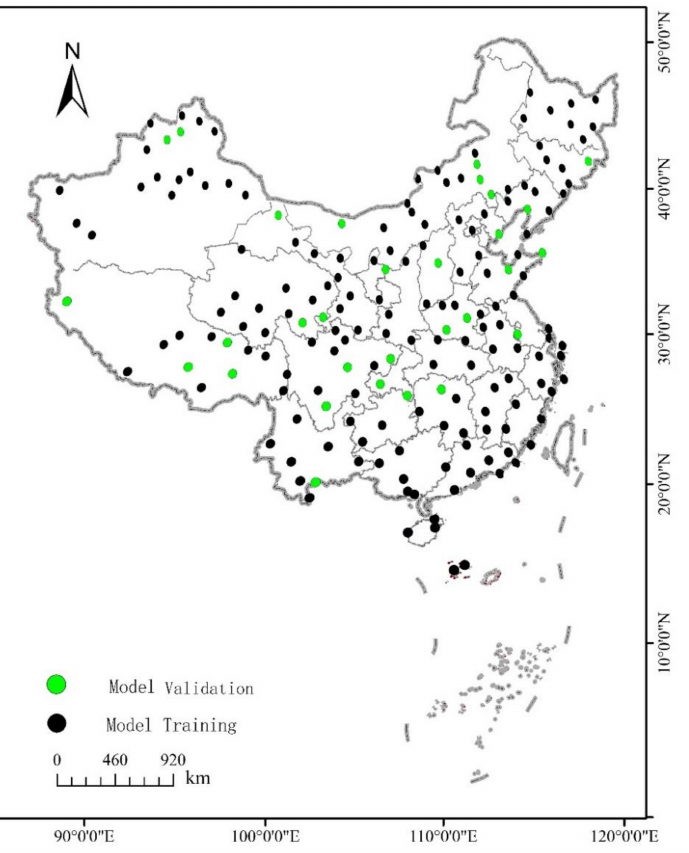
Figure 1. Distribution of the National Climate Reference Stations used for model training ( n = 155) and validation ( n =